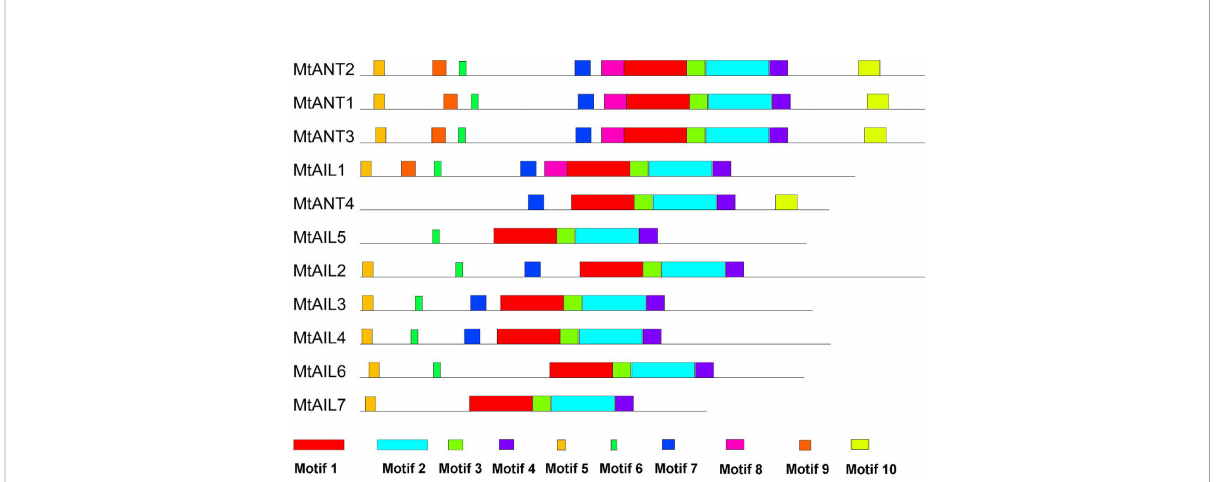
FIGURE 3 Motifs in MtAIL proteins. The motifs in MtAILs were indicated using MEME online tool. Motifs were represented by the boxes with different numbers and